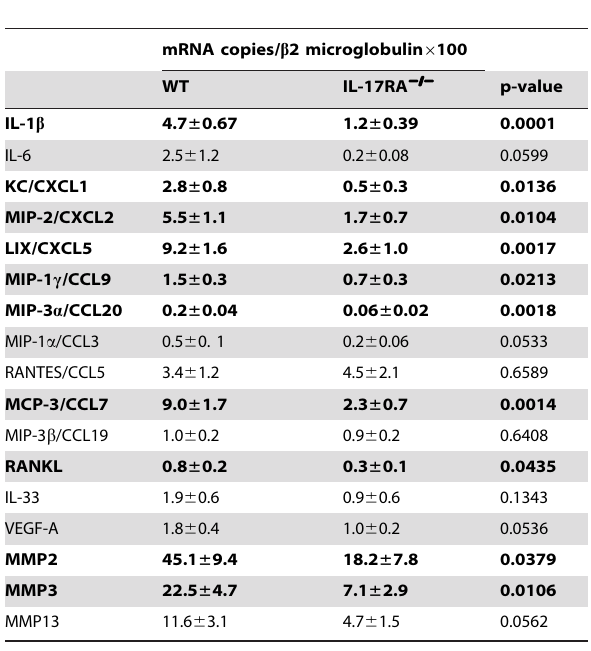
RNA expression in the ankles of wild-type and Il17ra 2 / 2 mice after serum- transfer. WT and Il17ra 2 / 2 mice were injected with K/BxN serum. On day 12, total RNA was harvested from whole ankle lysates and RNA levels assessed by qPCR. Data were normalized to the number of b 2 microglobulin mRNA copies. Results are presented as the 100-fold of the mean of mRNA copies/ b 2 microglobulin mRNA copies 6 SEM (n=13 mice per group). Data are compiled from three independent experiments. Differences were evaluated by unpaired two-tailed Student’s t test; p , 0.05 was considered statistically significant and is indicated in bold.